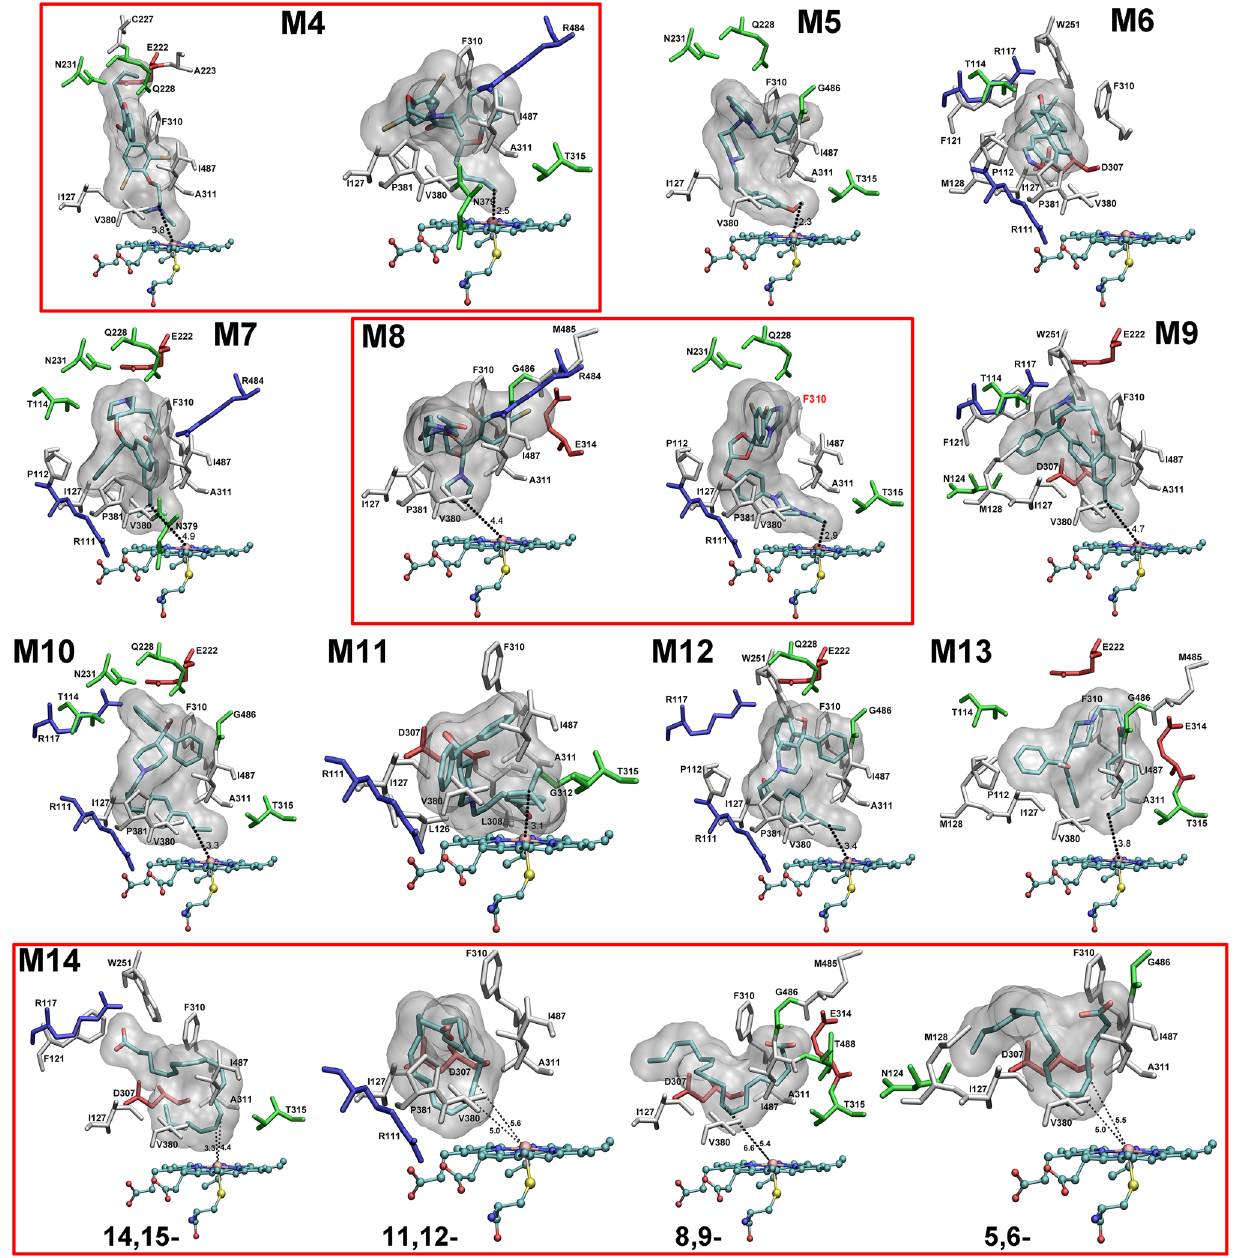
Figure 9. Summary of the preferred binding pose for M4 – M14 in the active site of CYP2J2. For M4 , M8 , and M14 , multiple binding poses corresponding to different metabolic pathways were shown. Residues in contact with the substrate were colored based on their types: blue for basic, red for acidic, green for polar, and white for nonpolar residues. The unit for the distance is . This figure was rendered using VMD 27 (http://www.ks.uiuc. edu/Resea Å